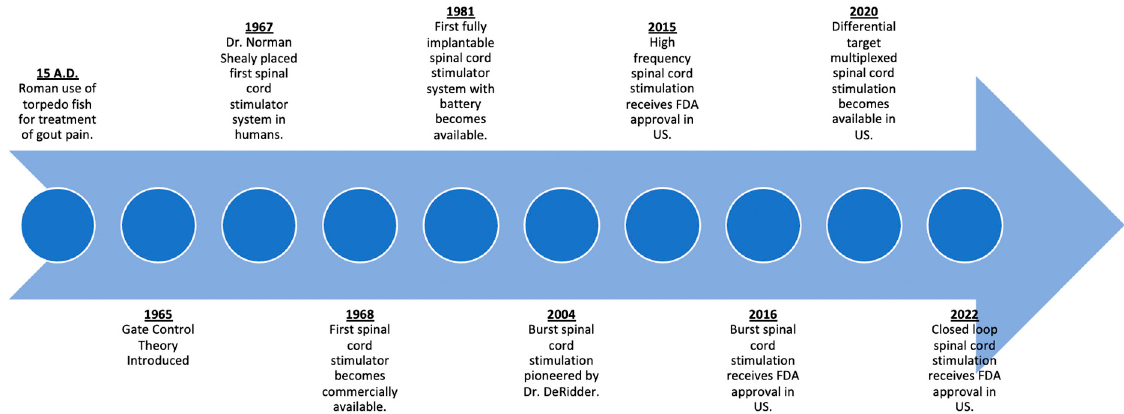
Figure 2. Timeline of advances in spinal cord stimulation.